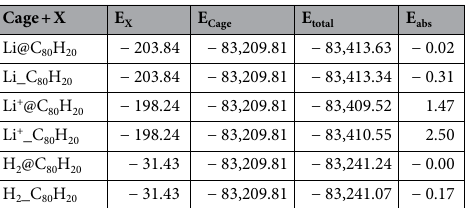
Table 5. Table of energy, X@C 80 H 20 means the particle is in the center of the cage, and X_C 80 H 20 for the particle in the face of the cage (in units